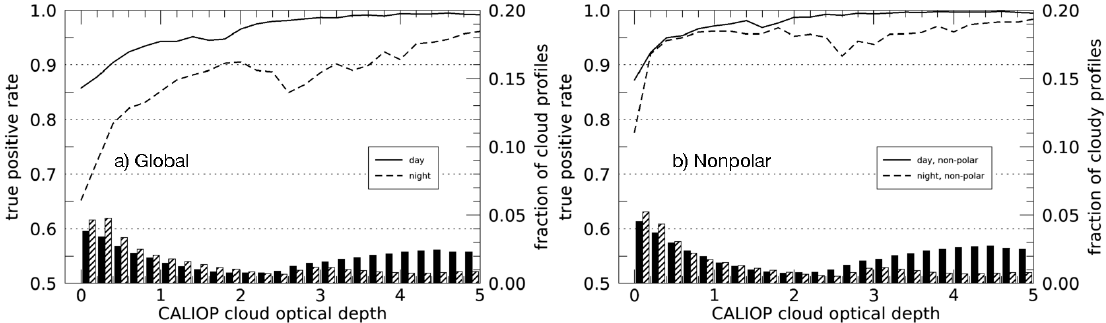
Figure 11. Dependence of CV1S true positive rate on COD C for 0/100 ice clouds, HA ≤ 1 km, JAJO 2015–2016. Solid (hashed) bars indicate fraction of cloud profiles for ( a ) day and ( b ) night observa- tions.